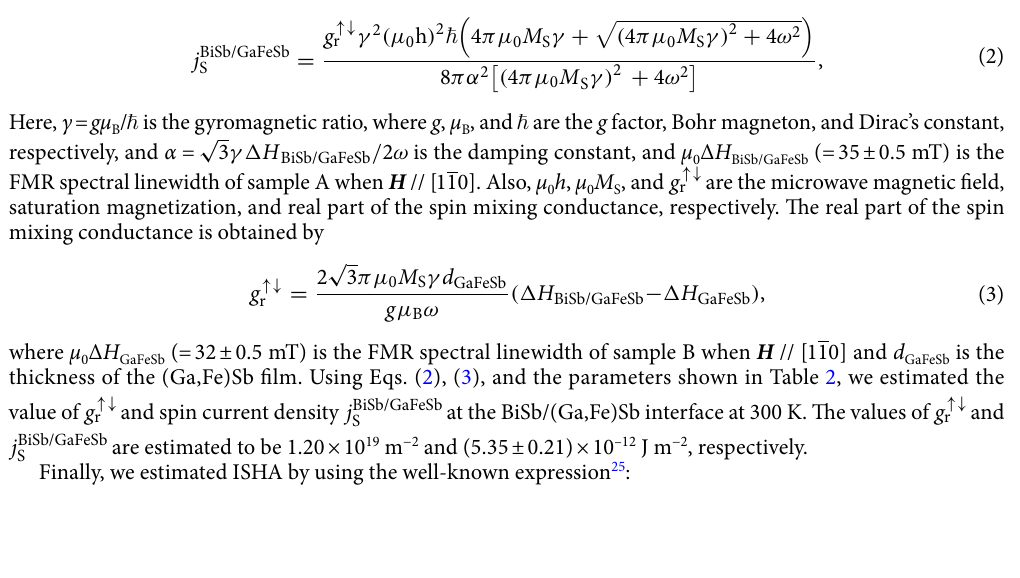
μ 0 Δ H BiSb/GaFeSb